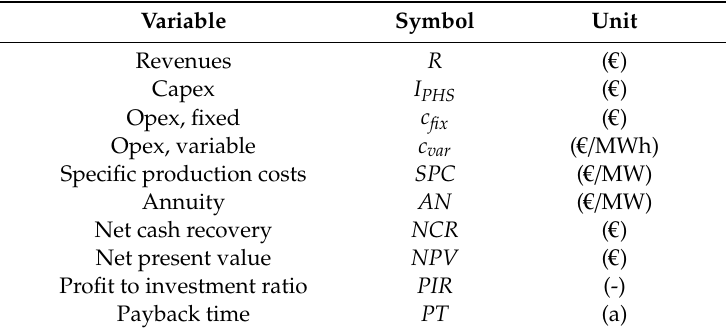
Table 7. Economic variables and symbols